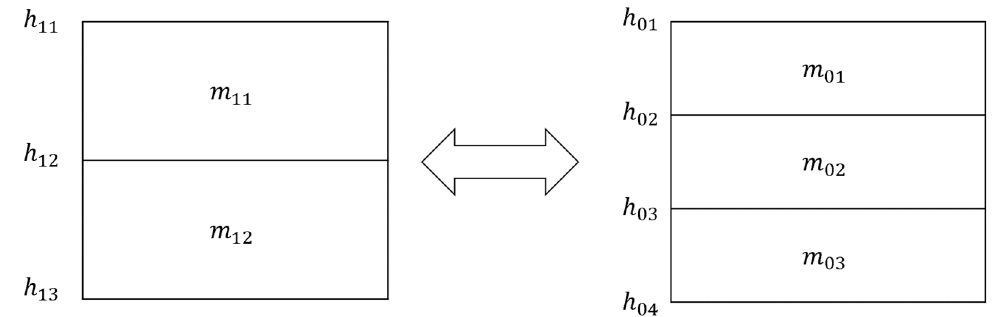
Figure 3. Schematic diagram of the 1D mesh mapping method.